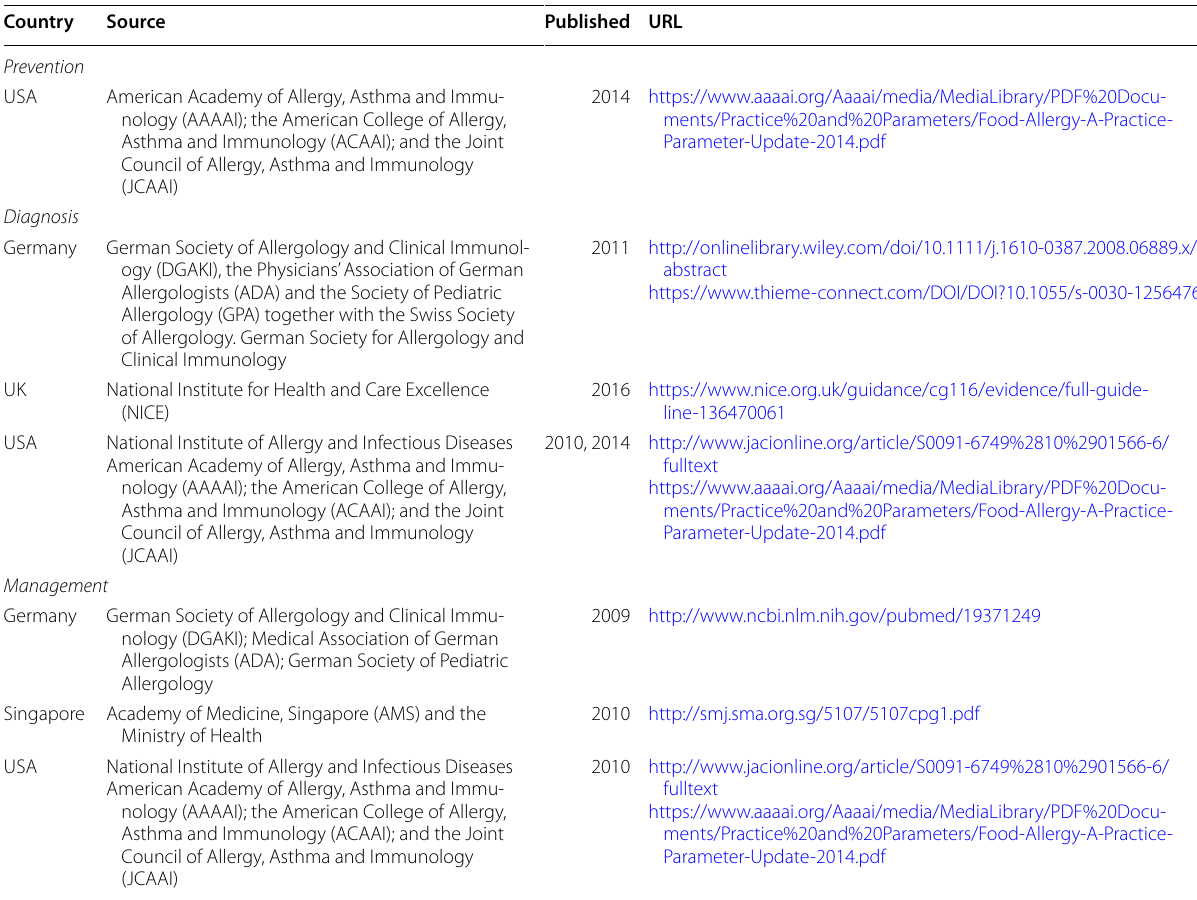
Table 2 National guidelines for food allergy